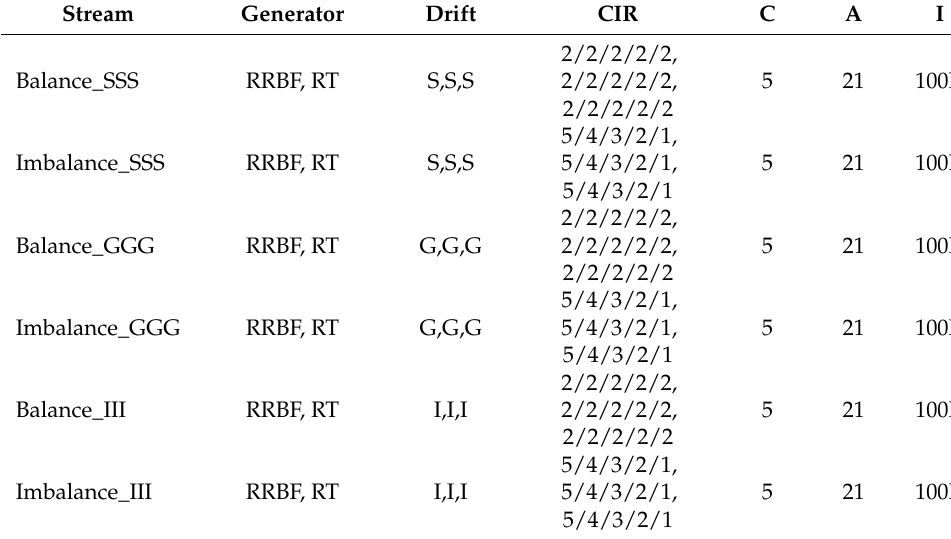
Table 2. Summary of generated data